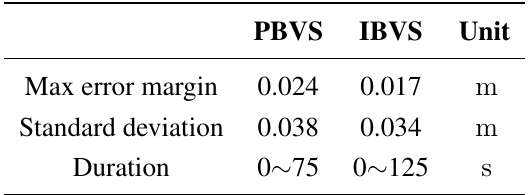
Table 3. Circum-navigation performance